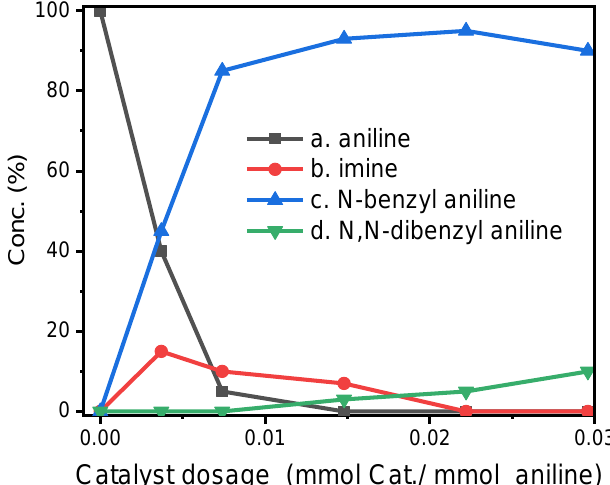
Figure 6. Composition distribution of N-alkylation reaction of aniline and benzyl alcohol under dif- ferent ratios of catalyst and aniline.